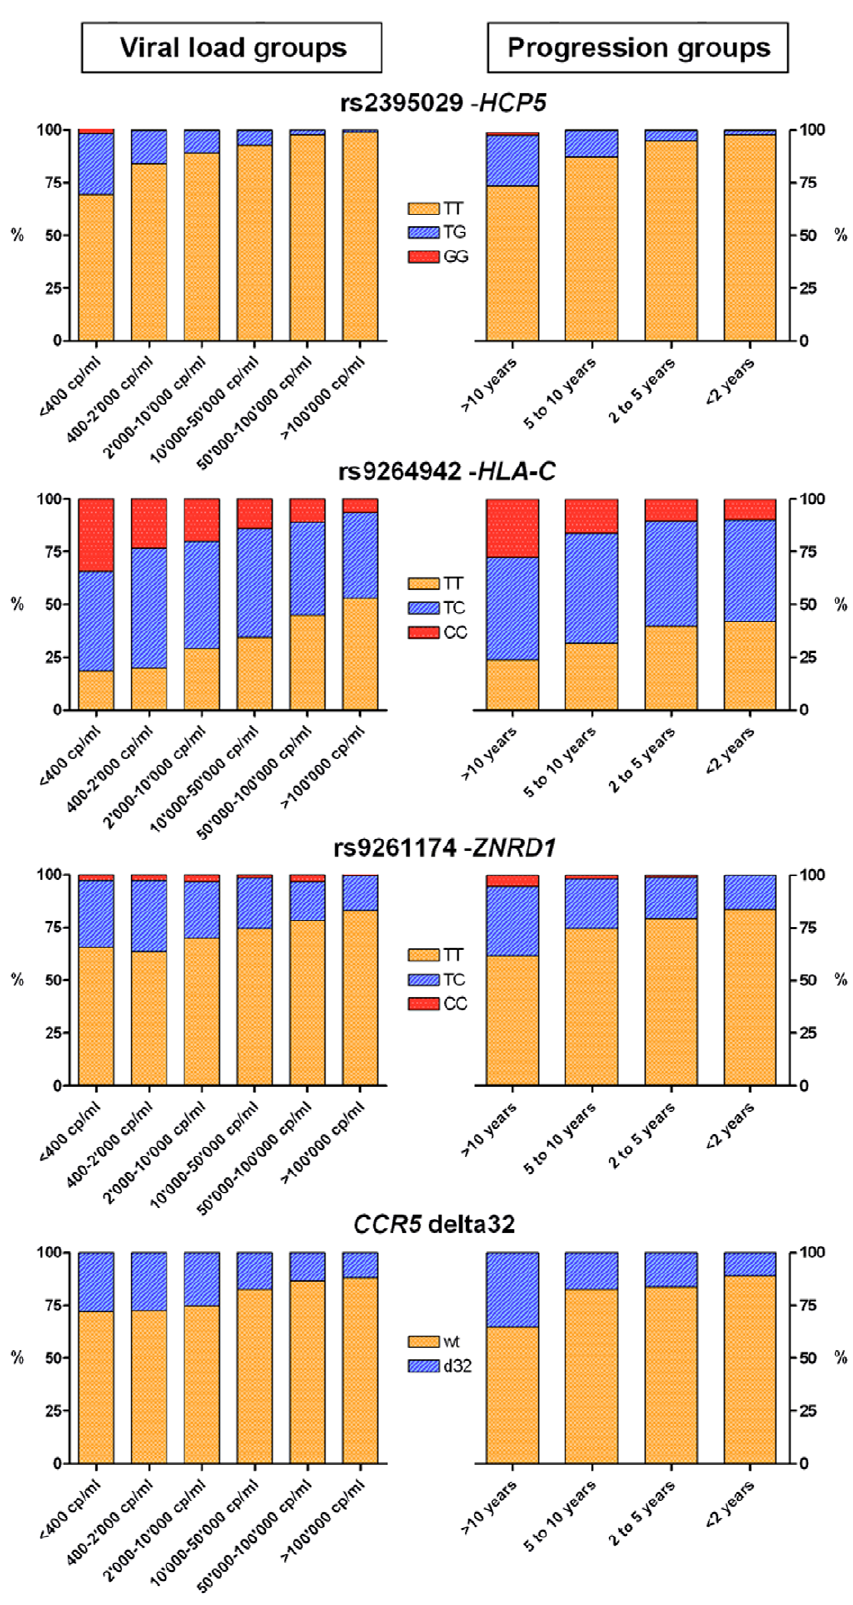
Figure 4. Allelic distribution of the significant variants in subsets of the study population. The bar graphs show the allelic distribution of the 4 variants that have a genome-wide significant association with HIV-1 set point and/or disease progression in subsets of the study population. Groups were defined according to HIV-1 set point (left-hand side graphs) and to progression time (right-hand side graphs).